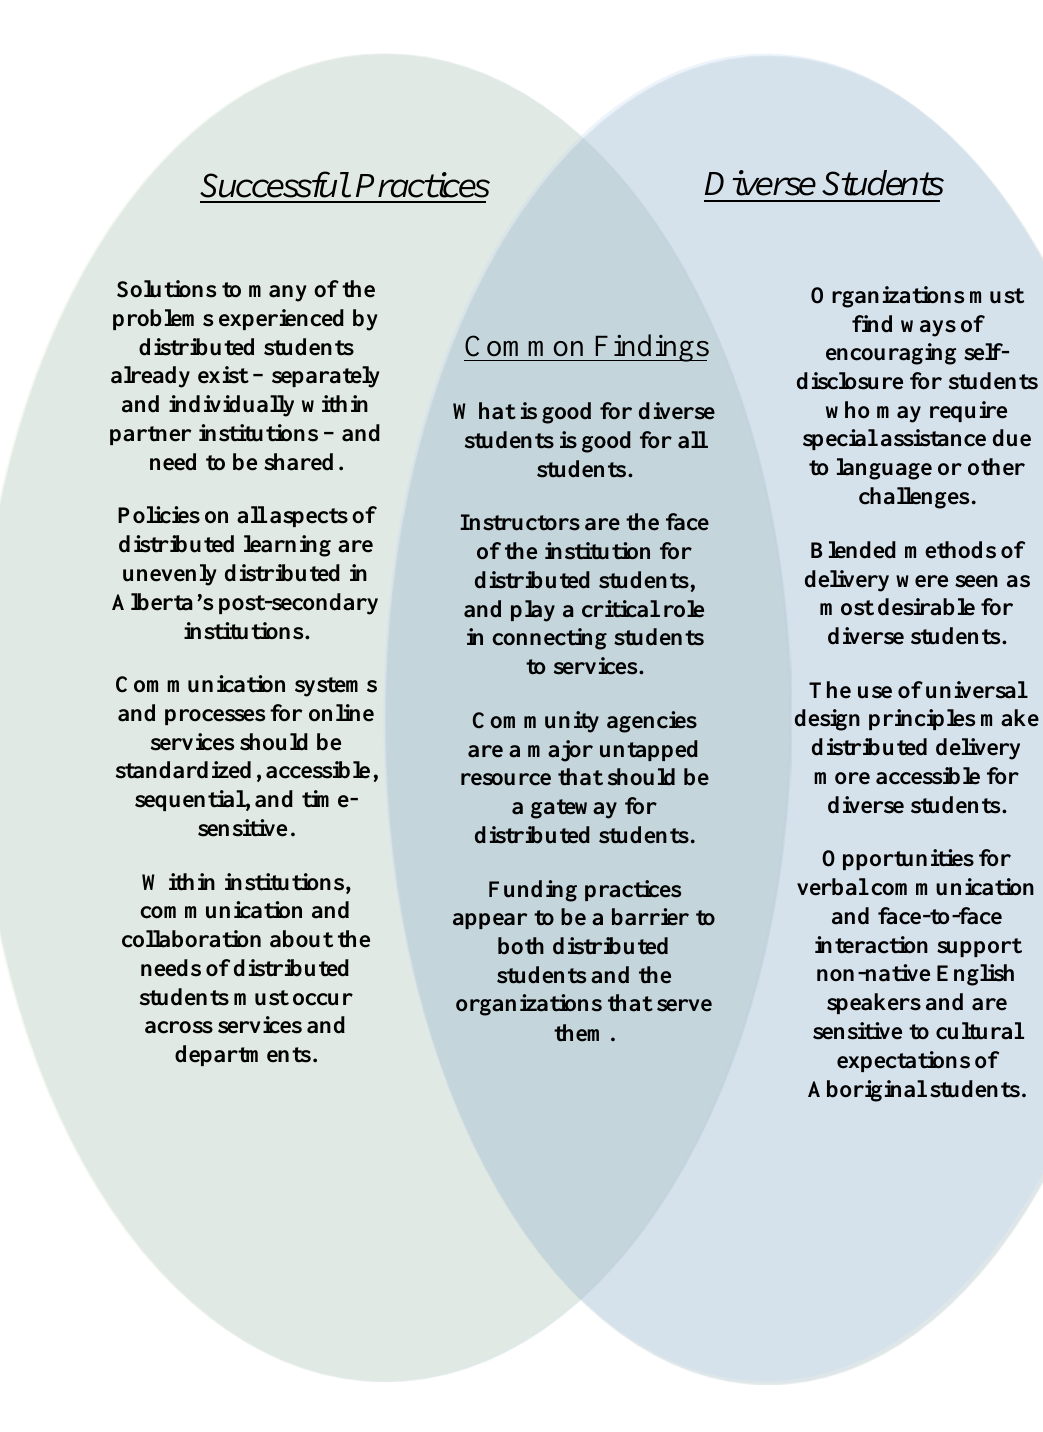
Figure 1. Key findings of the studies